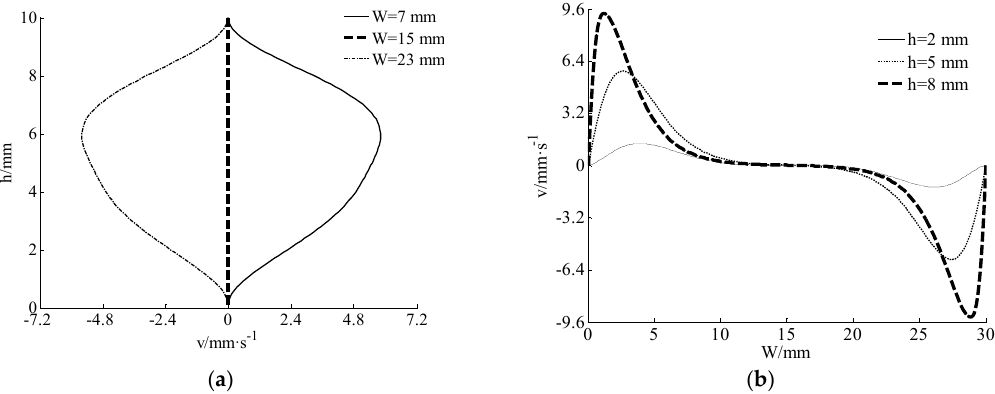
Figure 3. Distributions of the velocity component u at different directions: ( a ) velocity u -depth h , and ( b ) width W -velocity u.